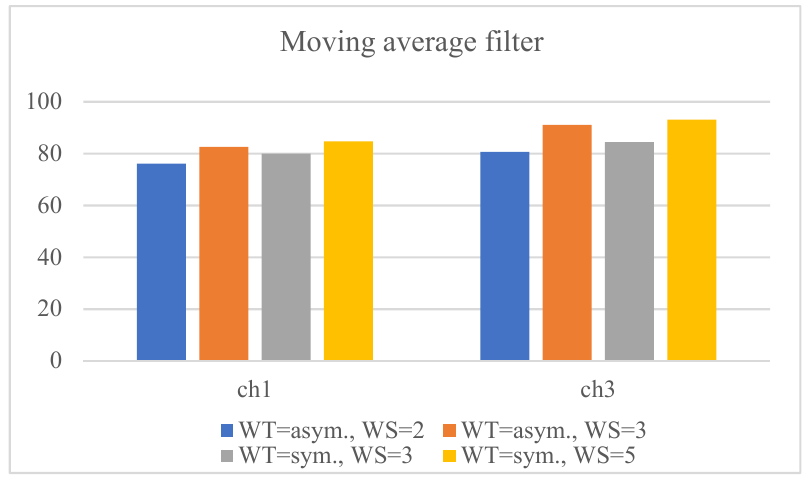
size 5. Figure 7. Percentages of relative difference for smoothness gained for the selected root-joint sig-